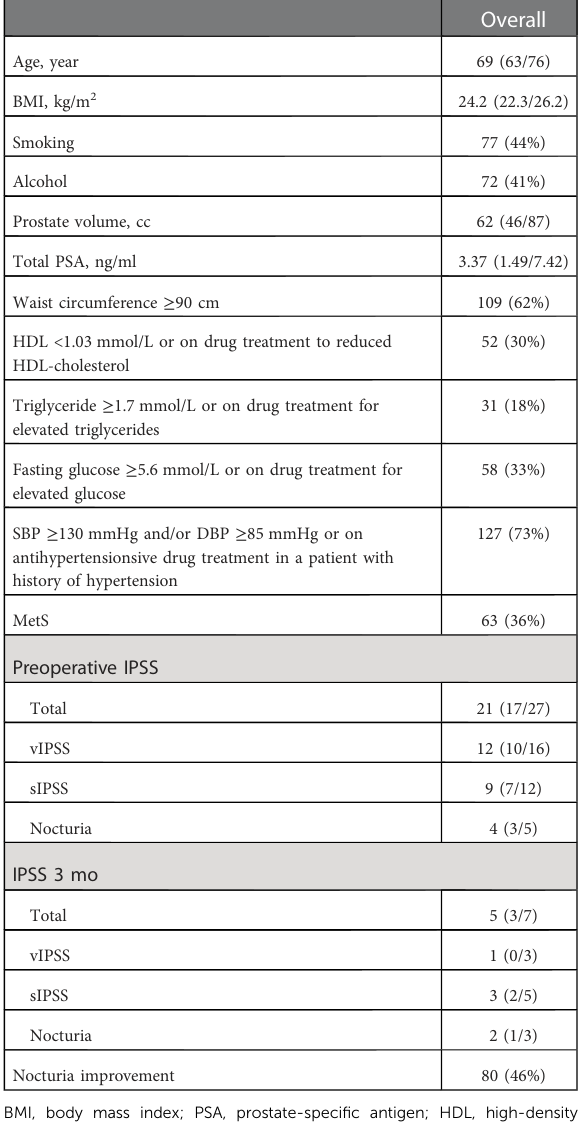
TABLE 1 Characteristics of the analyzed population ( n =175).